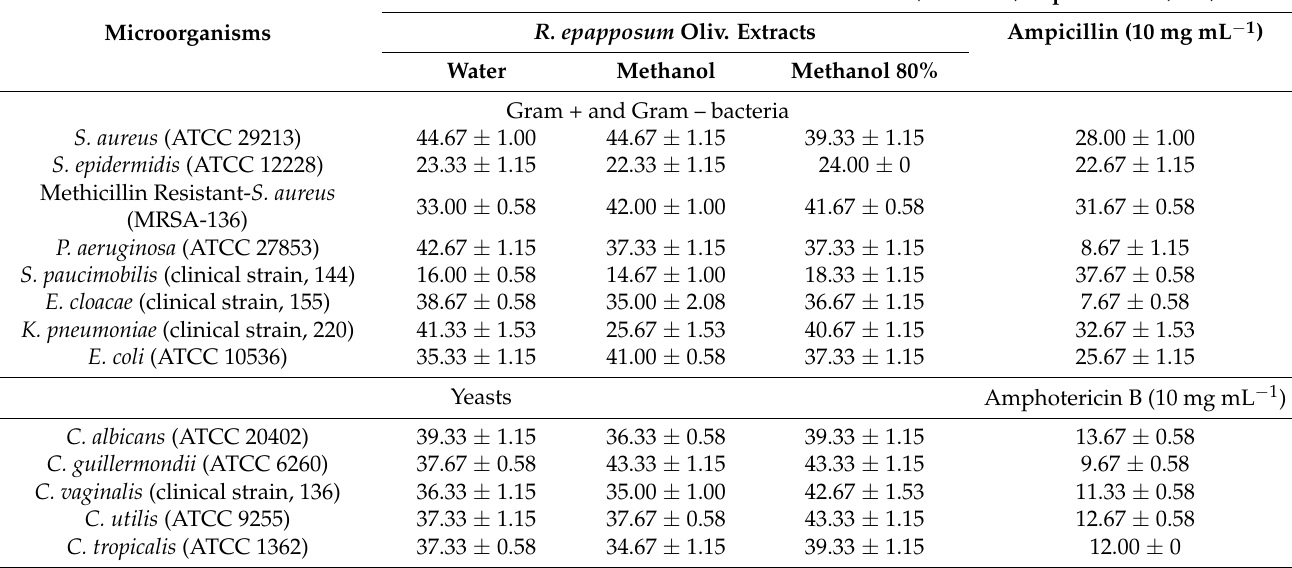
Table 5. Growth inhibition zone obtained for bacterial and fungal strains tested using well diffusion assay from aqueous, methanolic and 80% methanol extracts of R. epapposum